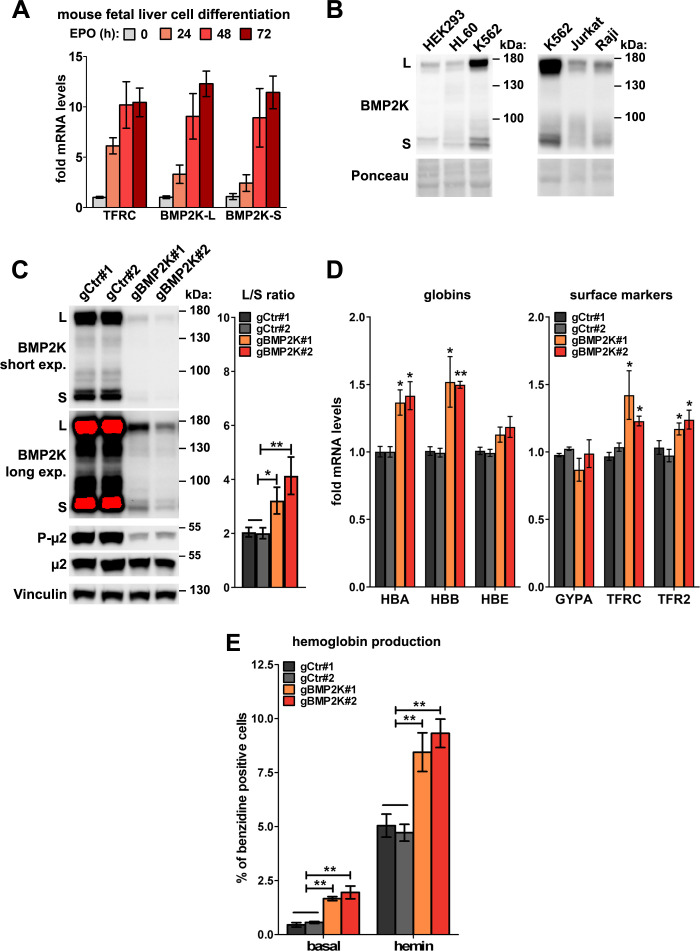
Expression of BMP2K gene in erythroid cells and the effect of its CRISPR/Cas9-mediated silencing on erythroid differentiation.(A) Fold changes in mRNA levels of transferrin receptor 1 (TFRC) as well as of the longer or shorter BMP2K splicing variants in erythroblasts isolated from mouse fetal liver and differentiated for the indicated time periods using erythropoietin (EPO)-containing medium (n = 4 +/- SEM). (B) Western blots showing the levels of BMP2K splicing variants in lysates from the indicated human cell lines. Ponceau staining serves as a gel loading control. (C) Western blots (short and long exposures) showing the efficiencies of depleting all BMP2K variants using CRISPR/Cas9 approach (gBMP2K#1 or #2) in K562 cells, and its effects on the levels of total and phosphorylated μ2 (P-μ2), as compared to non-depleted cells (non-targeting gRNAs, gCtr#1 and #2). Graph shows the L/S ratio calculated after densitometric analysis of western blotting results (n = 5 +/- SEM). (D) Fold changes in mRNA levels of the indicated erythroid markers in control cells or in cells depleted of all BMP2K splicing variants using CRISPR/Cas9 approach (n = 3 +/- SEM). (E) Percentage of benzidine-positive control cells or cells depleted of BMP2K using CRISPR-Cas9 approach, under basal growth conditions or after stimulation for 48 hr with 20 μM hemin (n = 4 +/- SEM). Values measured for BMP2K-depleted cells (C–E) were compared statistically to the average of values measured for gCtr#1 and gCtr#2-transduced cells. *p<0.05, **p<0.01.Figure 1—figure supplement 1—source data 1.Numerical data for graphs in Figure 1—figure supplement 1.